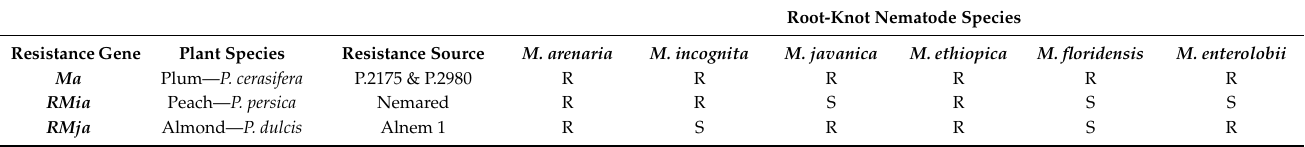
Table 1. Spectrum of resistance conferred by the R genes, Ma, RMia, and RMja, to six root-knot nematodes, Meloidogyne spp., attacking Prunus crops.